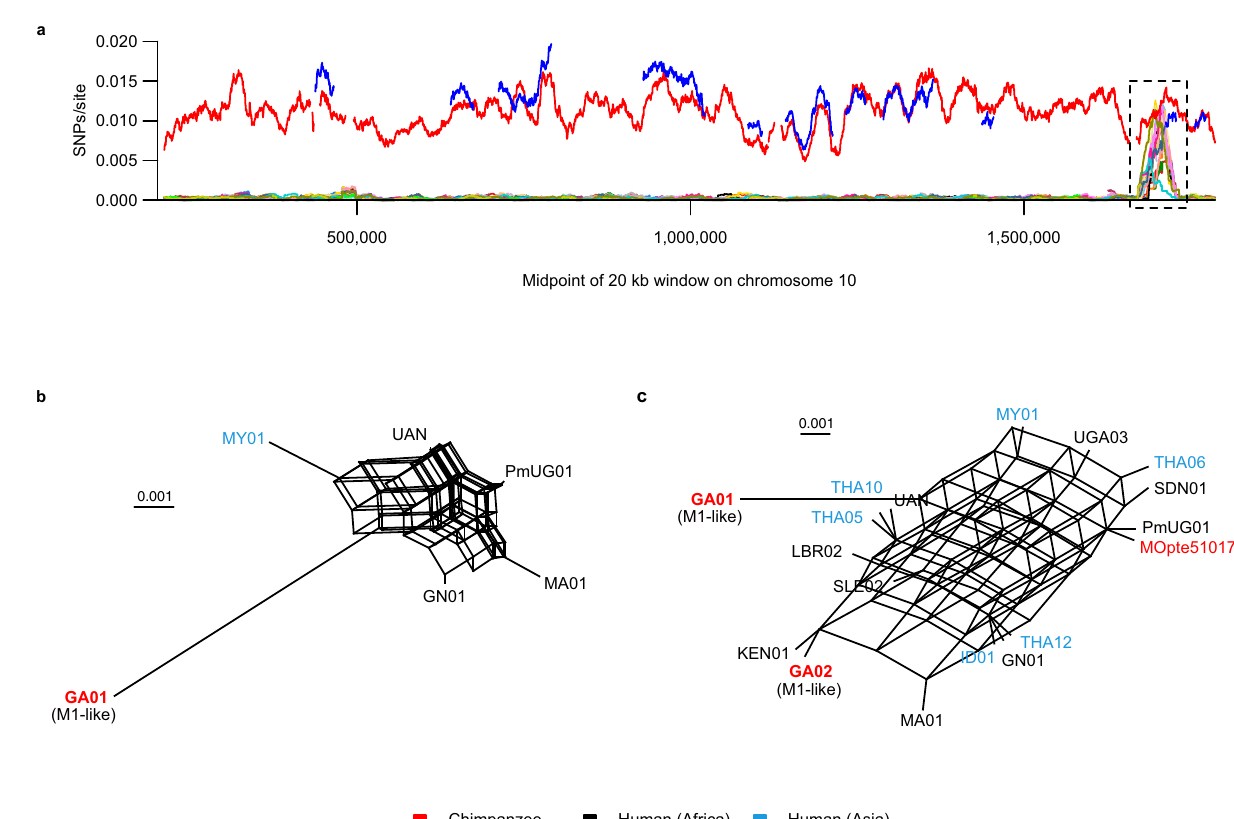
Fig. 5 A short region of high M1 diversity on chromosome 10. a Divergence (SNPs per callable site) from the M1 reference genome (PmUG01) is plotted for windows of 20 kb with a 100 bp step size; values are plotted at the midpoint of each window. Subtelomeric regions were not analysed and are not shown in the plot, and low-complexity and uncallable sites were changed to N. Only windows with at least 40% non-N bases were included, leading to gaps in the lines. The M1-like strains are represented as thick red (GA01) and blue (GA02) lines, and the remaining thin coloured lines represent M1 strains. M1-like strain Ptv_Leo does not appear because it had no 20 kb windows on this chromosome that met the criteria for analysis. The dashed black box highlights a region of approximately 45 kb (positions 1,680,100-1,723,901) where many M1 strains have unusually high divergence from the reference. A more detailed view of this region is shown in Supplementary Fig. 6. b Character-based phylogenetic network generated from 415 SNPs in the high-diversity region, analysing M1-like strain GA01 and the fi ve M1 strains that had coverage of most of the region. Pairwise nucleotide diversity among these M1 strains was 0.0063 substitutions per site. c Character-based phylogenetic network generated from 26 SNPs in the high-diversity region, analysing the 16 M1 and two M1-like strains with the highest genome coverage (Supplementary Table 4). To be included in the networks, we required a variant site to be covered by all strains, and many strains had coverage gaps at different sites, hence adding more strains usually decreased the number of SNPs analysed. Strain names in the networks are coloured according to their host or geographical orgin, as indicated in the key. Scale bars indicate 0.001